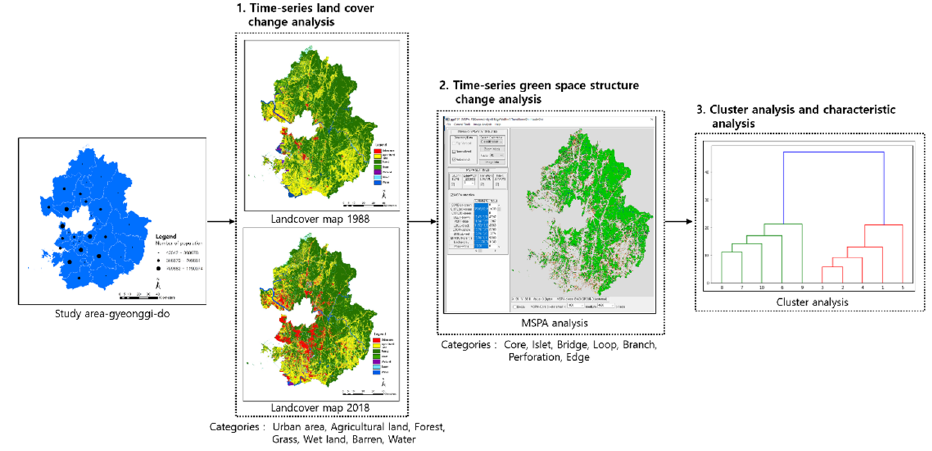
Figure 2. Research flow.